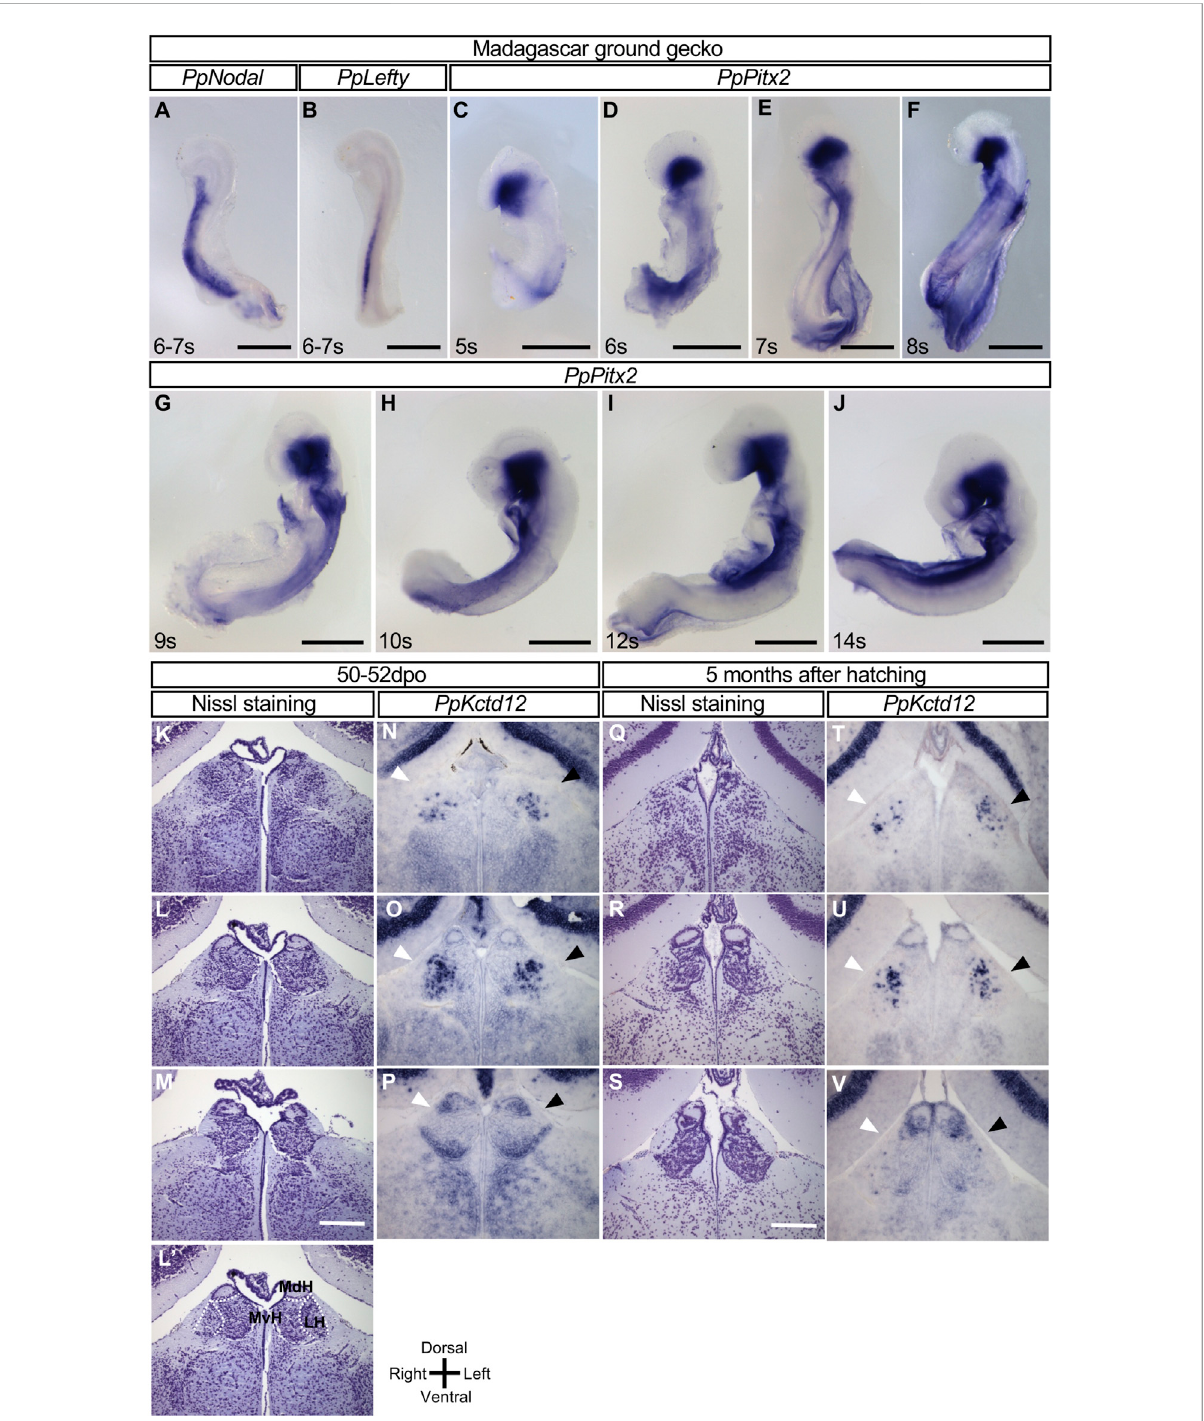
FIGURE 3 Lack of L-R asymmetric expression of Nodal , Lefty , and Pitx2 in the developing brain of the Madagascar ground gecko. (A – J) Whole-mount in situ hybridizationanalysisof Nodal (A) , Lefty (B) ,and Pitx2 (C – J) expressioninthedevelopingbrainofgeckoembryos.Thesegenesarenotexpressed in the developing brain, whereas their expression is apparent in other regions. The embryos were obtained before oviposition (9 – 10 days after the previous oviposition) (A – F) or at 0 to 1 dpo (G – J) . The number of somites (s) is indicated for each embryo. Scale bars, 0.5 mm. (K – P) The habenula ofgeckoatthe50 – 52dpo. Nissl stainingoffrontal sectionsatthelevel of thehabenulaisshown fromtherostral side (K) to thecaudalside (M) . Dotted lines in (L ′ ’ ) indicate the subdivision of the habenula shown in section (L). MdH, MvH, and LH denote the medial dorsal habenula, medial ventral habenula, and lateral habenula, respectively. Kctd12 expression in the habenula as examined by in situ hybridization with frontal sections are